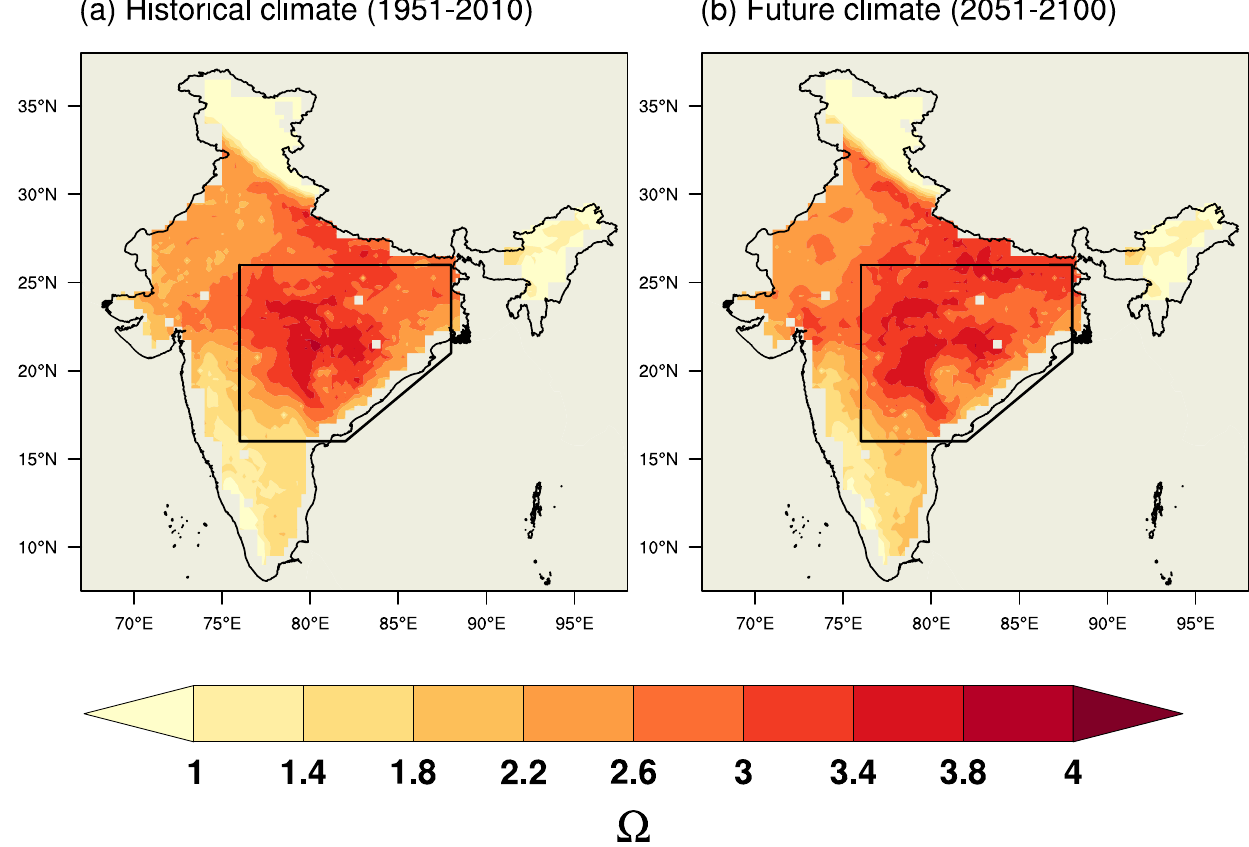
Fig. 3 Soil moisture-temperature coupling. Spatial maps of soil moisture-temperature coupling over the Indian region estimated using the method by Dirmeyer 38 for the ( a ) HIST and ( b ) FUT experiments. The area shown in the polygon over north-central India (NCI) is highlighted as the region of strong soil moisture-temperature coupling over India (75°E-87°E, 16°N-26°N, land